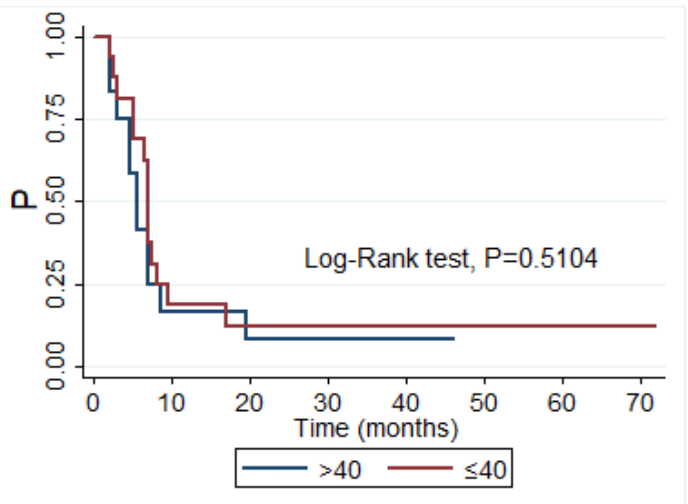
Figure 2. Kaplan–Meier 30 months progression survival curves of grade IV glioma patients ac- cording to sHLA-G, patients with sHLA-G < 40 ( n = 17), patients with sHLA-G > 40 ( n = 12), X-axis—progression-free survival time in months, Y-axis—survival probability in months without progression (test: Log rank p =